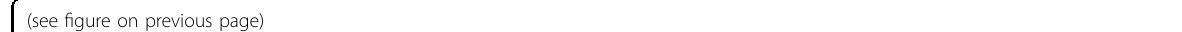
Fig. 7 Overexpression of N fi l3 attenuates Treg cell identity. a Scatterplot of RNA-seq data. RNA-seq analysis was performed using total RNA isolated from control or N fi l3 -overexpressing Treg cells. b Gene Ontology analysis of genes differentially expressed in control or N fi l3 -overexpressing Treg cells. Gene set enrichment analysis (GSEA) plots for genes in the categories cytokine activity ( c ) and regulation of α : β T-cell differentiation ( d ) in control or N fi l3 -overexpressing Treg cells. In vitro plasticity assay. e Schematic of the plasticity assay. f qRT-PCR analysis of N fi l3 mRNA in Treg and media-changed cells, which were cultured under Th1- or Treg-polarizing conditions, respectively. g Naive CD4 T cells were transduced with control or N fi l3 -overexpressing vector on day 1, and the cells were cultured as in e . IFN- γ and Foxp3 levels in each cell type were measured by fl ow cytometry. Dot plots are representative of three individual experiments. Error bars represent the SD. Statistical differences between groups were determined by Student ’ s t test. * P < 0.05, ** P < 0.01, *** P < 0.001; and **** P < 0.0001. n.s. not signi fi cant